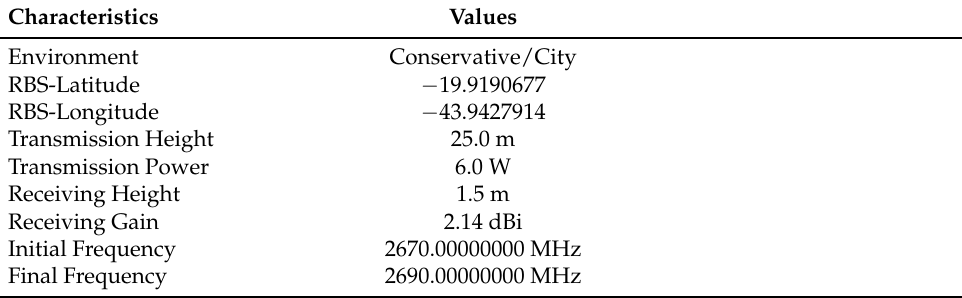
Table 4. Characteristics and values about the used